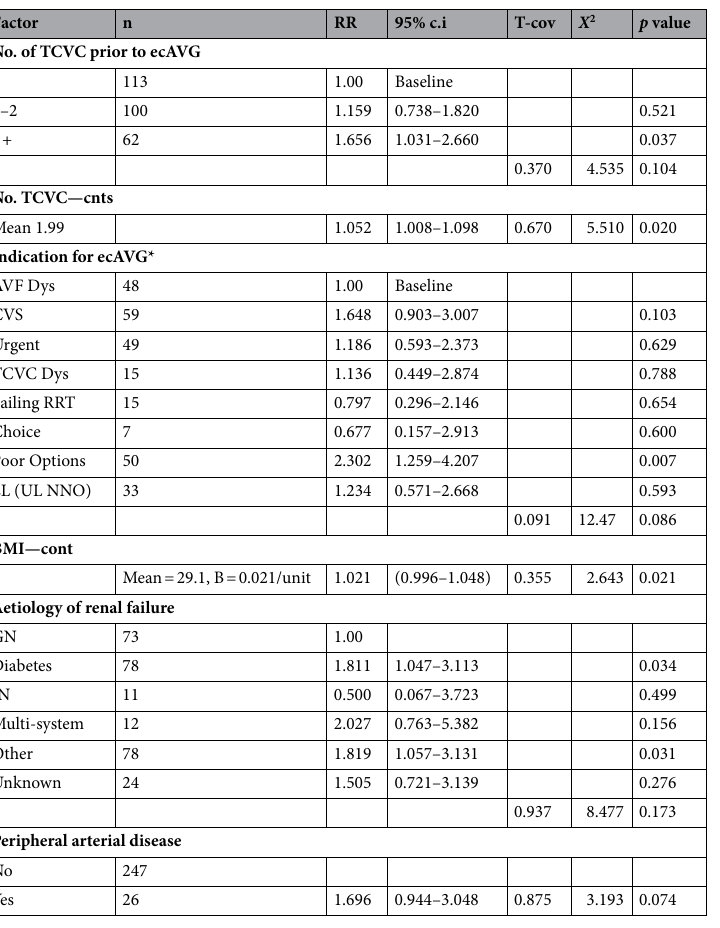
Table 4. Univariate analysis of risk of ecAVG survival (loss of functional patency): significant/ near significance factors. AVF/G Dys dysfunction of an existing AVF or AVG, TCVC Dys dysfunction of a previously functioning TCVC, PNO poor native options, CVS central vein stenosis with HeRO or lower limb AVG, LL (UL NNO) lower limb AVG as upper limb had no native options, GN glomerular nephritis, Diabetes diabetes mellitus, IN interstitial